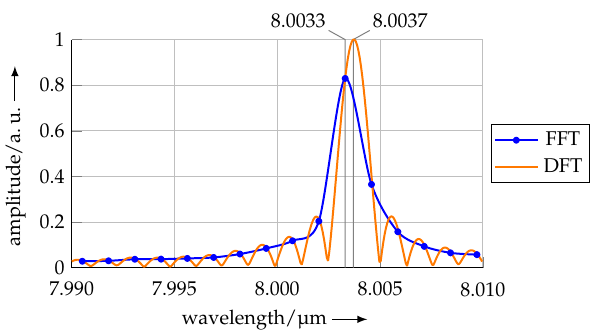
Figure 12. The resolution limitation of the FFT causes the maximum calculated amplitude not to be equal with the true maximum amplitude, visible in the DFT. However, the FFT maximum was used as initial parameter for the maximum search algorithm utilising a